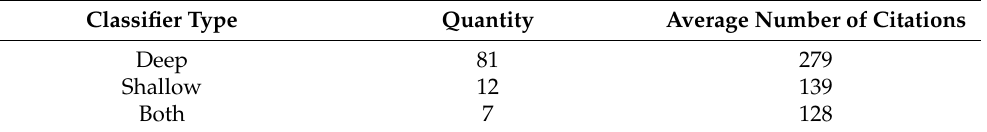
Table 7. Classifier type.